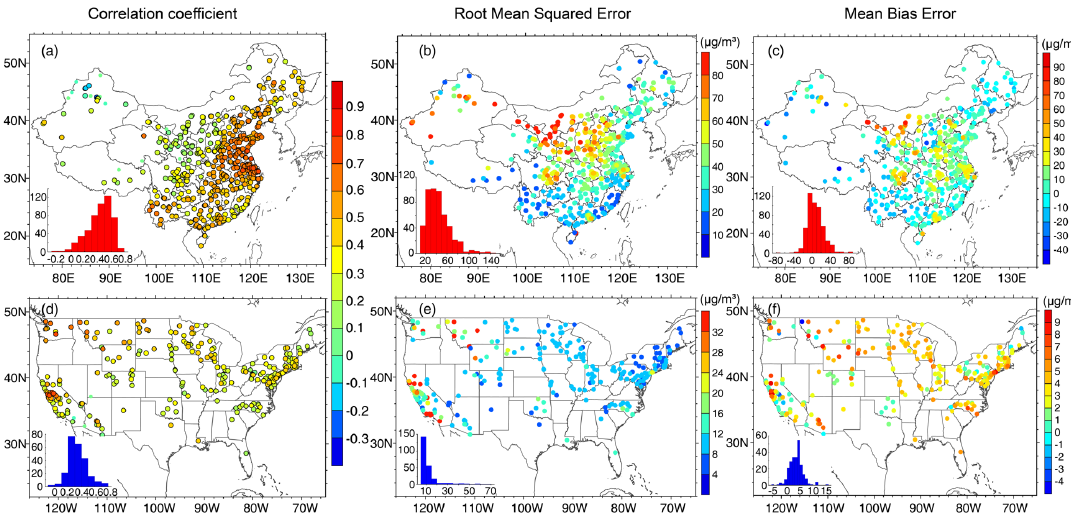
Figure 1. Data accuracy of PM 2.5 forecasts from the the European Copernicus Atmosphere Monitoring Service (CAMS) with a forecasting time horizon of 3 h (step-3) in China ( a – c ) and United States (US) ( d – f ). Dots with a black edge in ( a , d ) imply correlations were statistically significant at the 95% confidence interval.